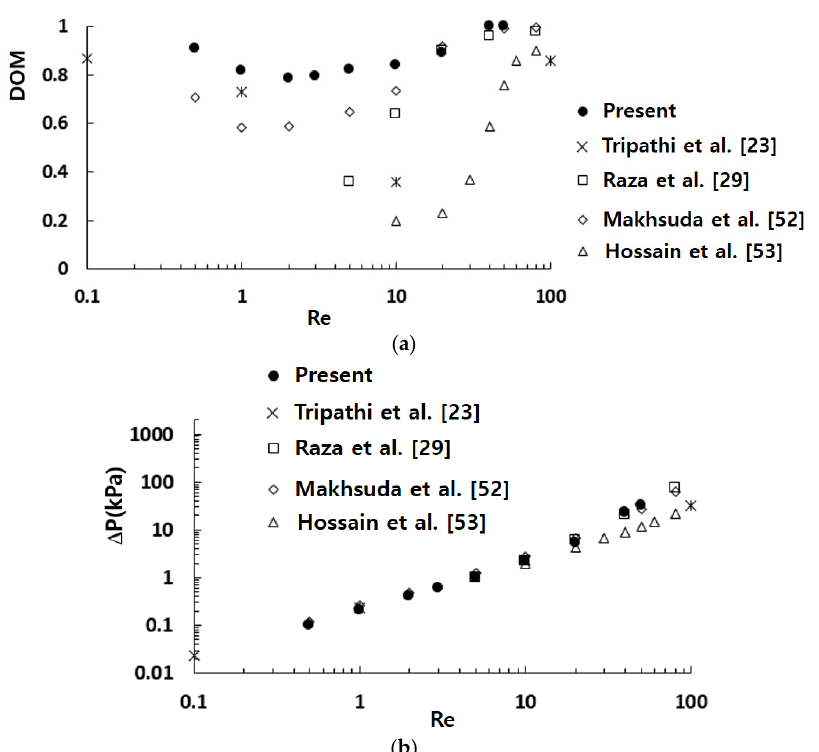
Figure 13. Comparison of the simulated mixing performance with other micromixers. ( a ) DOM vs. Re . ( b ) Pressure load vs. Re .